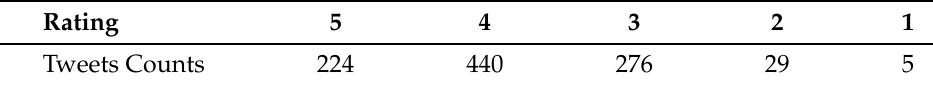
Table 7. Annotation summary—5 scale